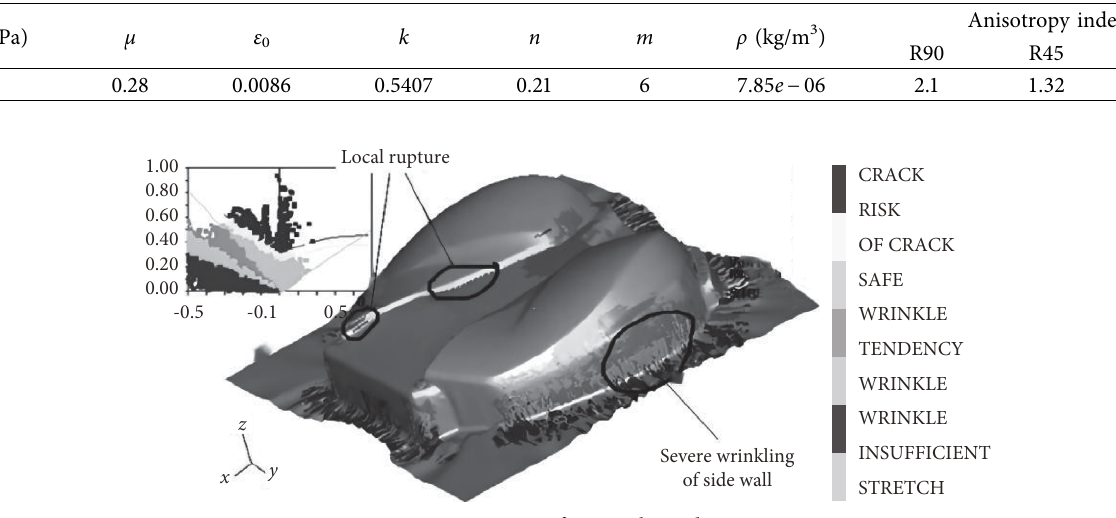
Table 1: Material parameter